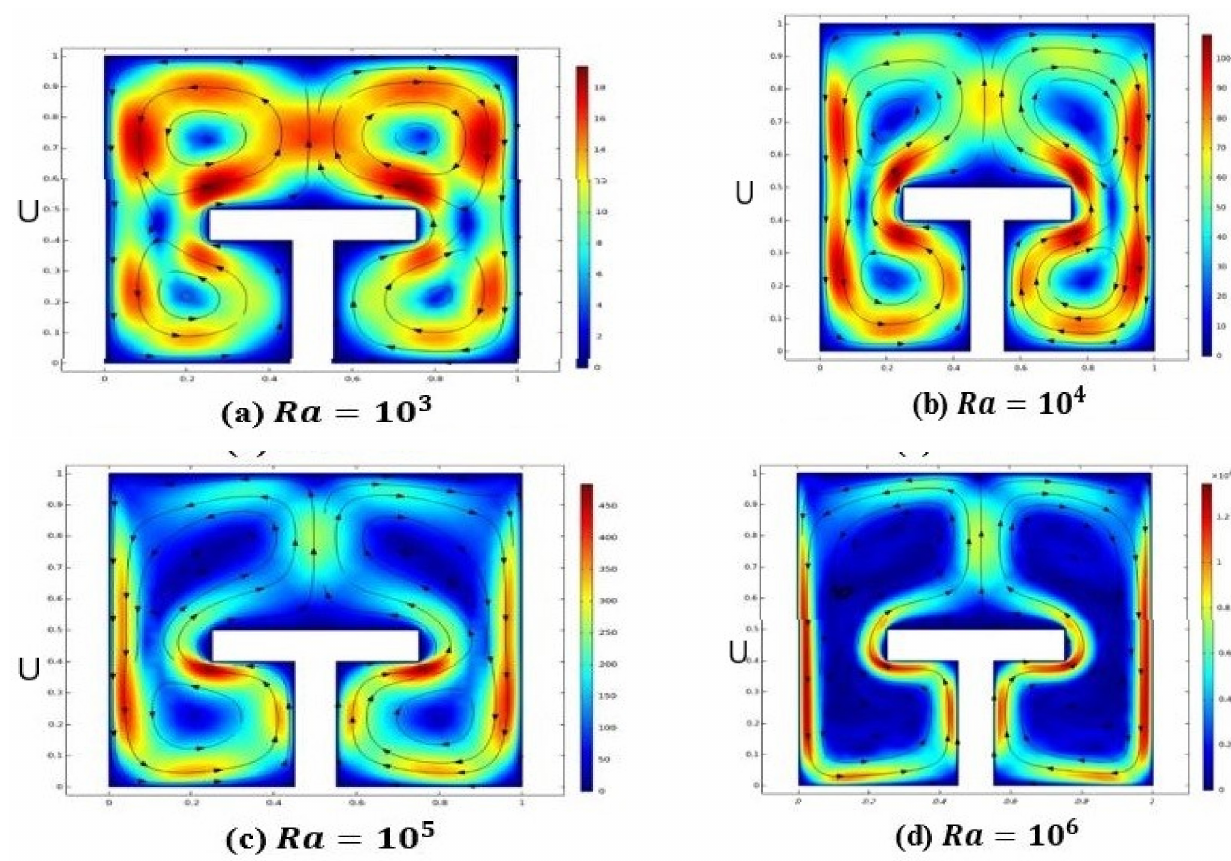
Figure 7. Variation in velocity distribution against ( Ra ).